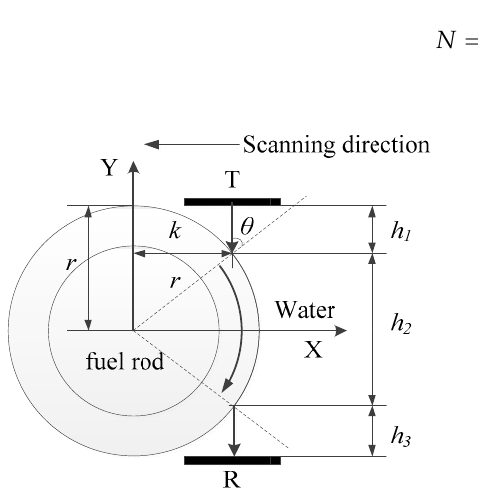
Figure 2. The diagram for avoiding influence of near-field region.